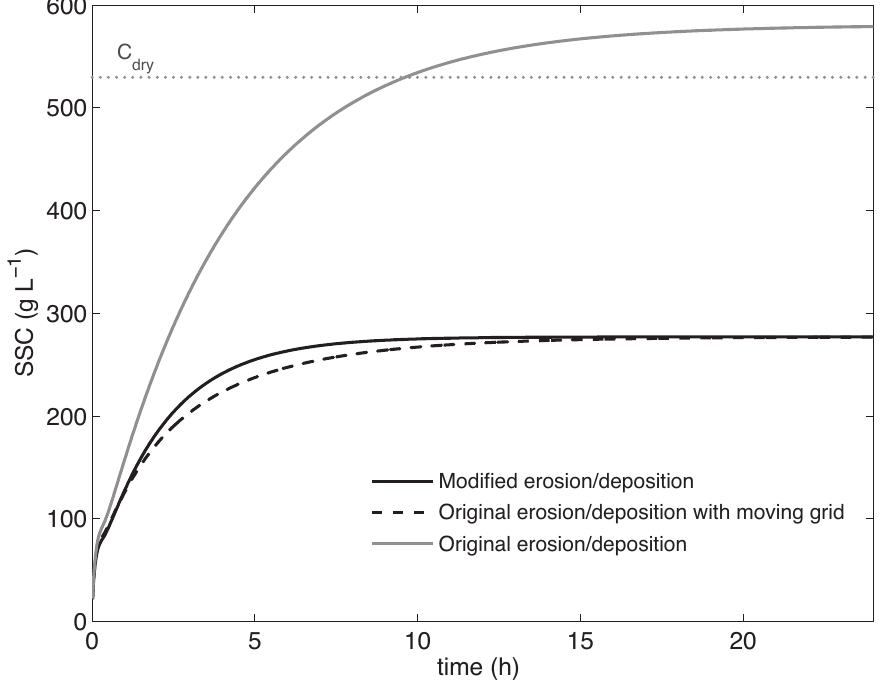
Figure 3. Time series of SSC at the bottommost cell in the cases of modified erosion/deposition formulation with fixed grids (black solid line), original formulation with moving grids (black dashed line), and original formulation with fixed grids (gray solid